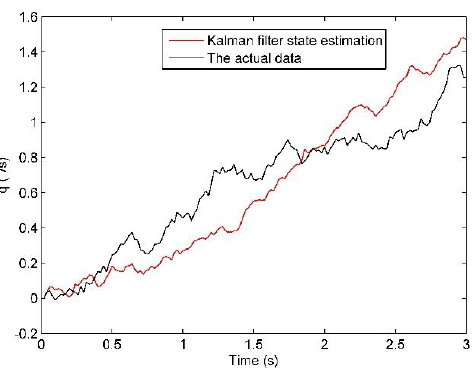
Figure 2. Kalman filter state estimation under the interference of approximate control signal noise.